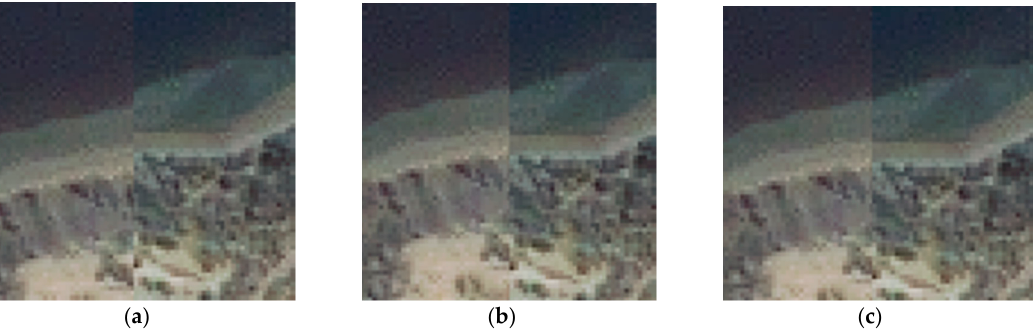
Figure 14. Local Registration result on Dataset 2. ( a ) Registration result by Lee’s method. ( b ) Registration result by Li’s method. ( c ) Registration result by the proposed method.